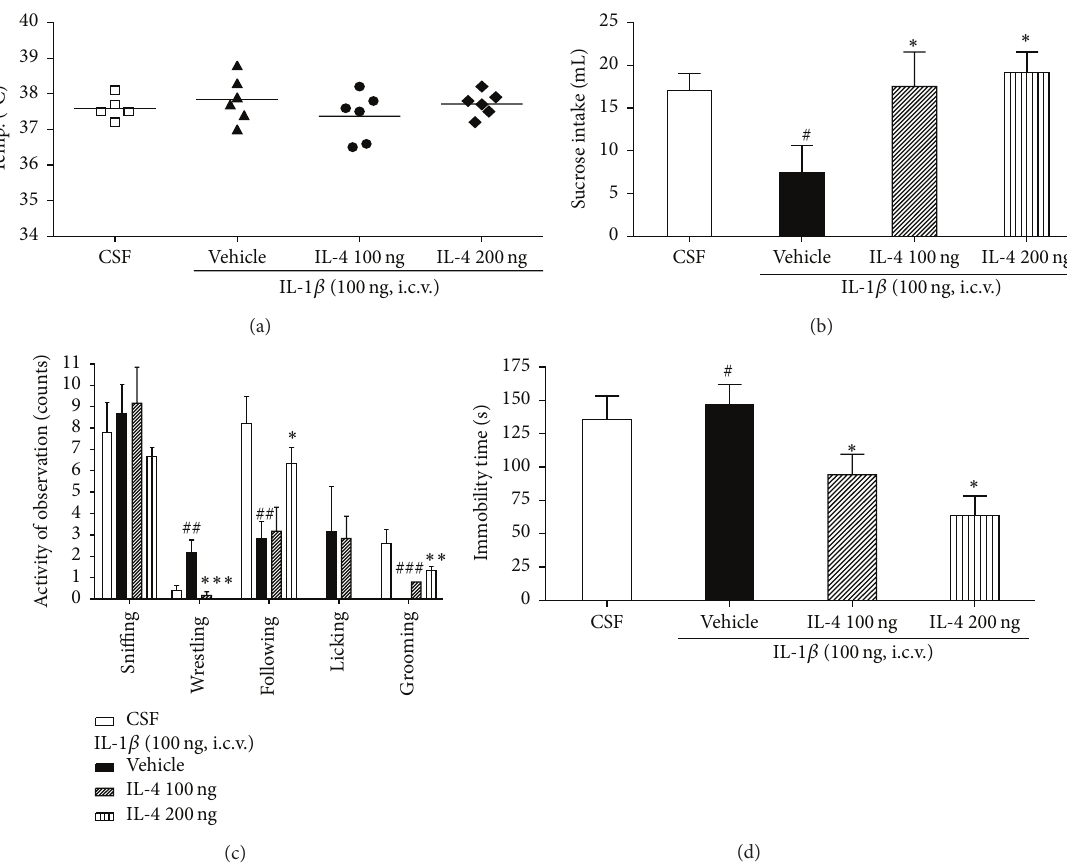
Figure1:EffectofIL-4injection2hoursafterinjectionofi.c.v.IL-1 𝛽